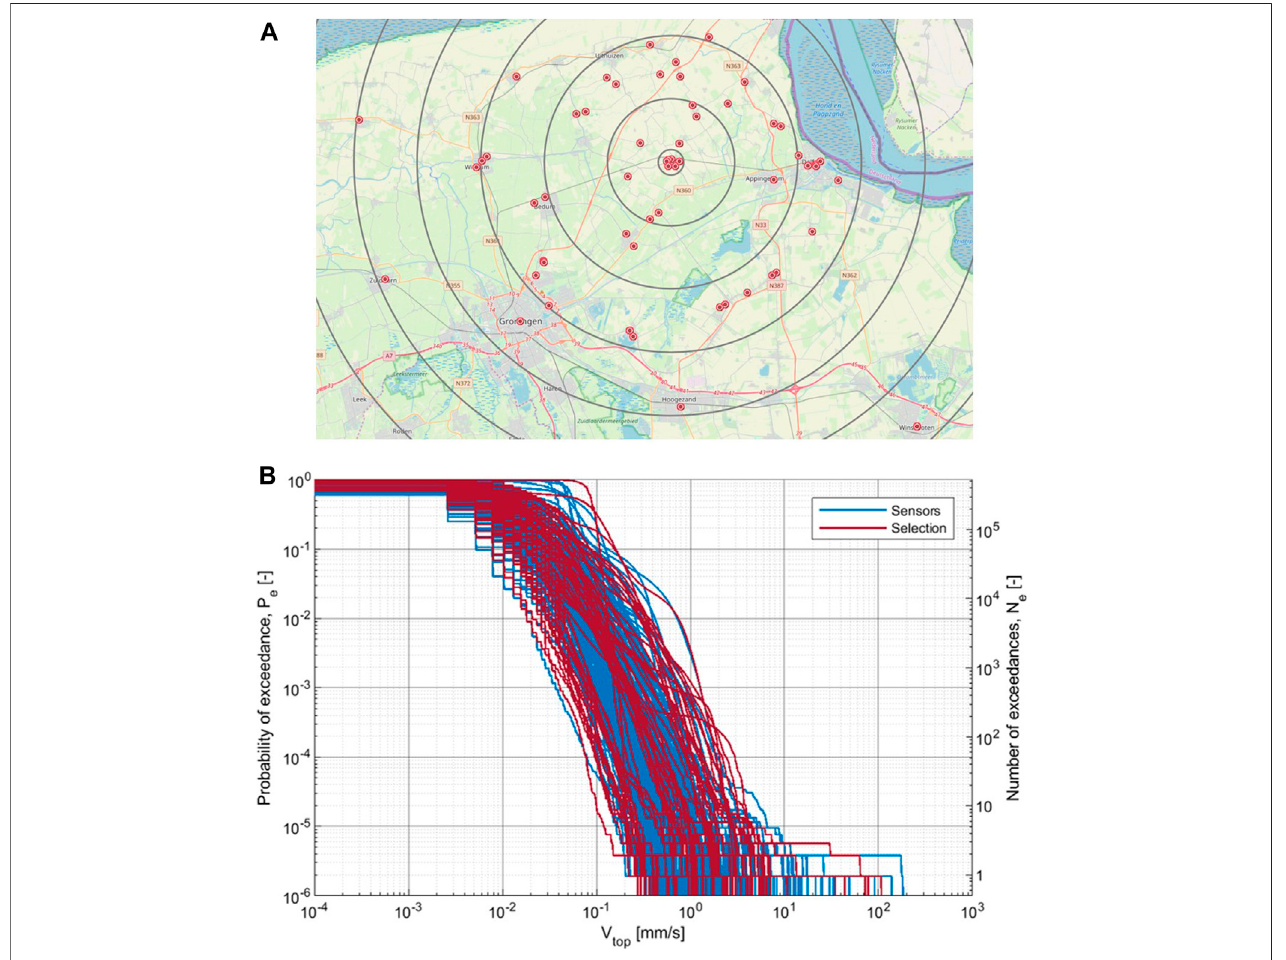
FIGURE 7 | (A) Position of the selected sensors for analysis of the full operational period. The red dots indicate the selected sensors while the grey circles indicate the distance from Loppersum (1, 5, 10, 15, 20, 25, and 30 km). (B) CCDF curves of the 1-year dataset (blue) and of the selected sensors (red).